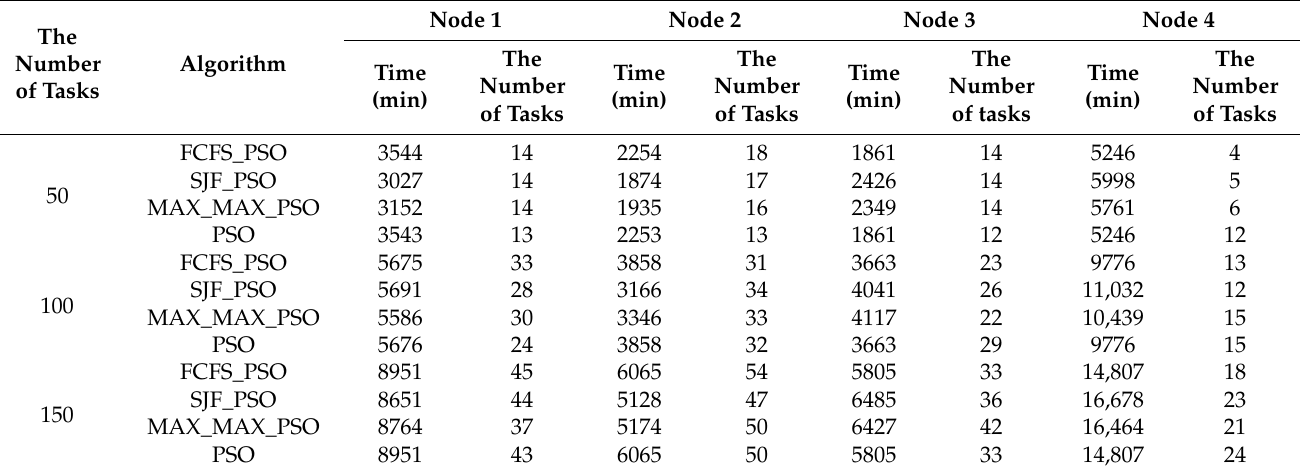
Table 2. Task execution results of different algorithms.